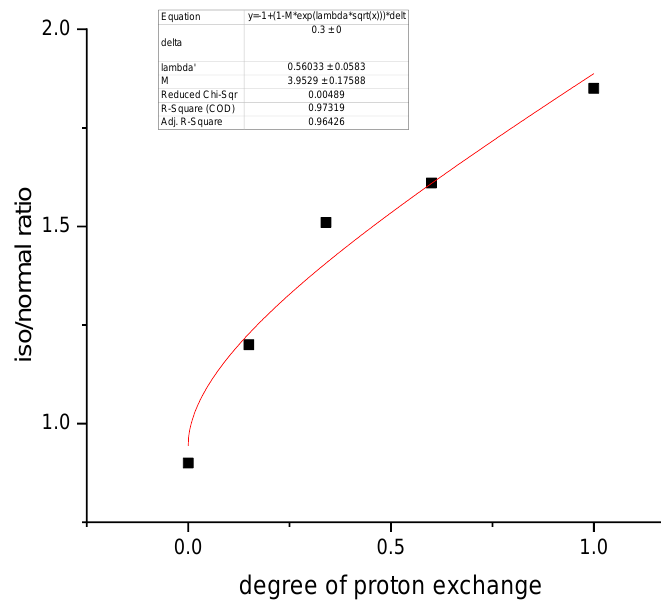
Figure 5. Dependence of the ratio of iso to normal hydrocarbons vs. a degree of proton exchange in transformations of syngas over mesoporous H-ZSM-5 supported cobalt nanoparticles. The experi- mental data are digitalized from [30].